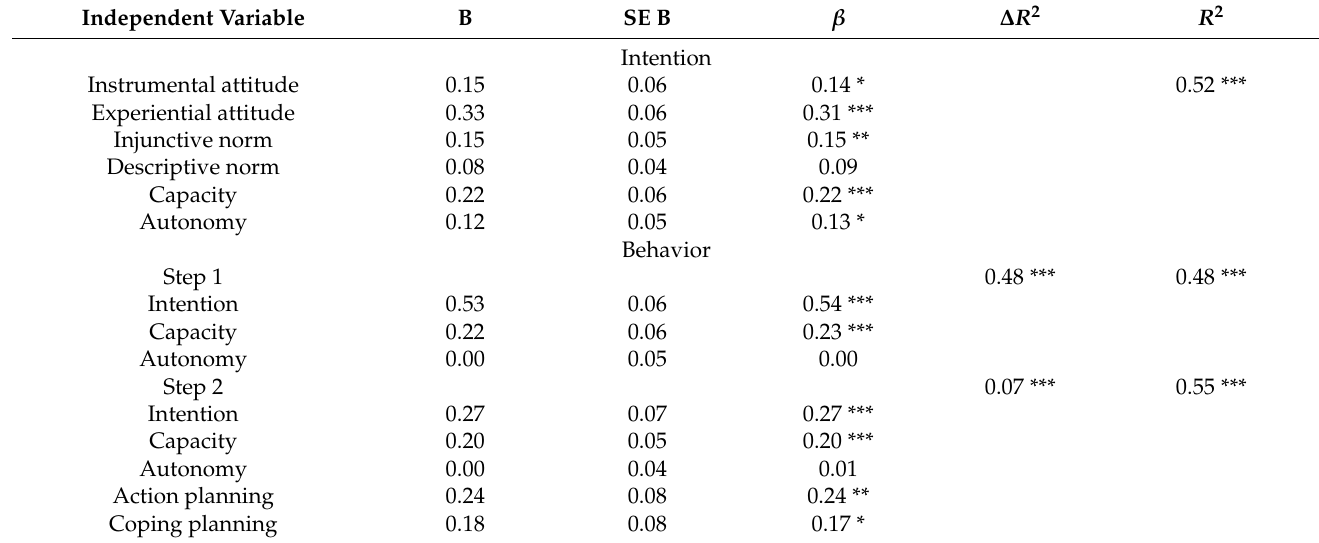
Table 2. Regression analyses predicting physical activity intention (N = 273) and behavior (N = 256).